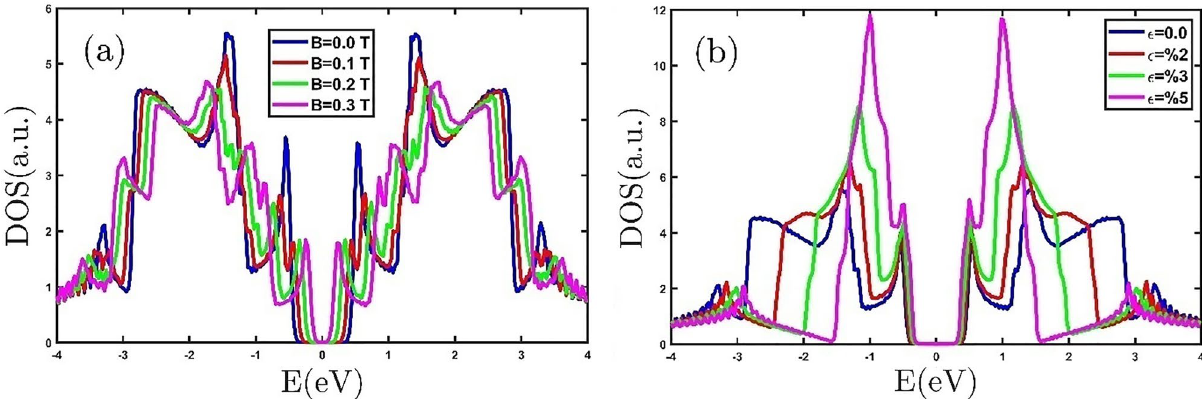
Figure 2. The electronic DOS of the GeCH 3 SL ( a ) in the presence of different external magnetic fields and ( b ) for different tensile biaxial